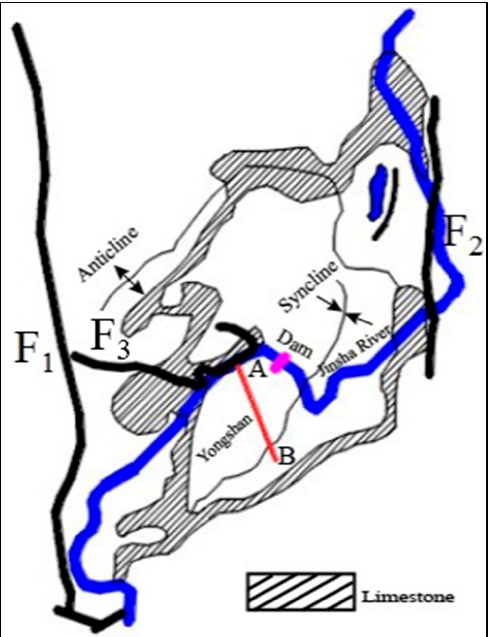
Figure 2. Basic geological structural map of Xiluodu area. F1 is the Majingzi fault, F2 is the Jiziba fault, and F3 is the Majiahe fault.